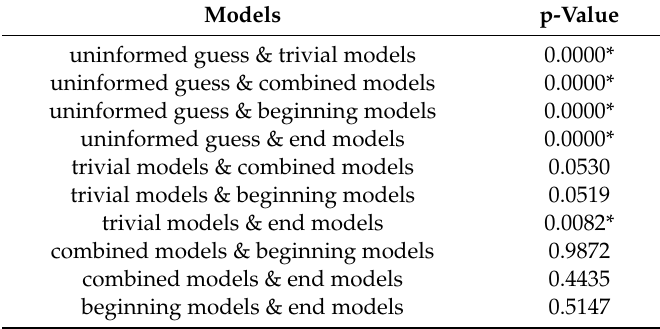
Figure 3. Boxplot of comparing uninformed guess and the accuracy of trivial models with three different RFc (5k trees) models that use FF4 and optimal threshold (combined, beginning and end models). The accuracy of all the RFc models is better than the uninformed guess and the trivial models, with end models obtaining the best accuracy, followed by combined models and beginning models. The crosses represent mean values, the boxes show 25% and 75% quantiles and the median, while the whiskers show the minimum and maximum values. Table 3. Paired U-test for comparing the results of the uniformed guess, trivial, combined, beginning and end models using RFc (5k) with FF4 and optimal threshold.